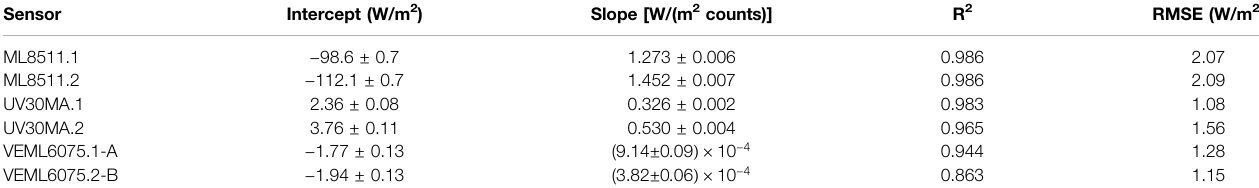
TABLE 1 | Statistics of the linear regressions between the modeled irradiance and the output voltage of the sensors of the study. Sensor Intercept (W/m 2 ) Slope [W/(m 2 counts)] R 2 RMSE (W/m 2 ) ML8511.1